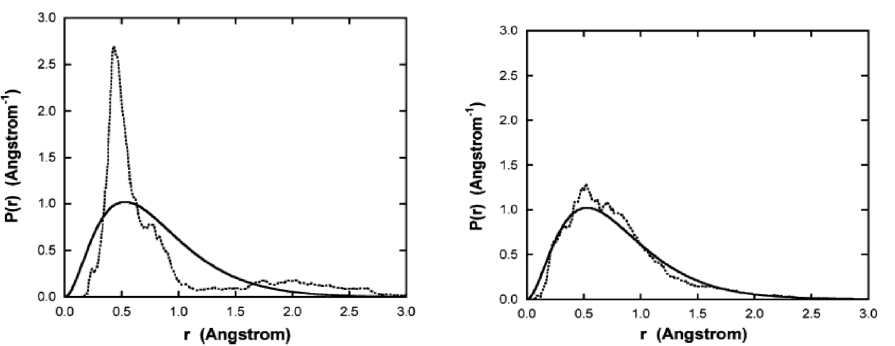
Figure 3. Plots of the radial probability density vs. radius. The solid line was calculated from the ground state Schrodinger wavefunction. The dotted curves are simulation results, with starting trajectories began at 0.53 Å calculated as a time average for all 11 simulation runs from t = 0 to the indicated time: left side, 1.417 × 10 − 12 sec, right side, 7.25 × 10 − 12 sec. Figure from [3] with